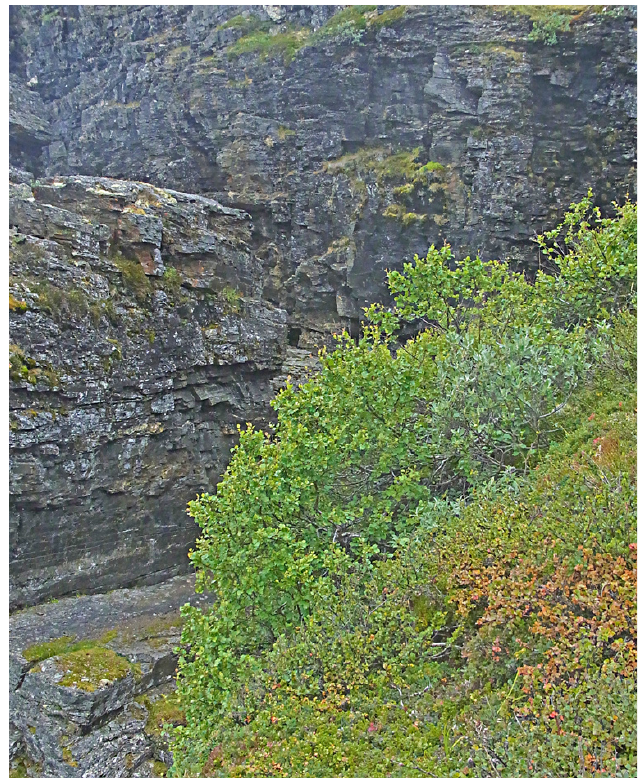
Figure 43: The current (2010) birch treeline in Kåppas Valley (870 m a.s.l.), about 3 km northeast of Kåppas-